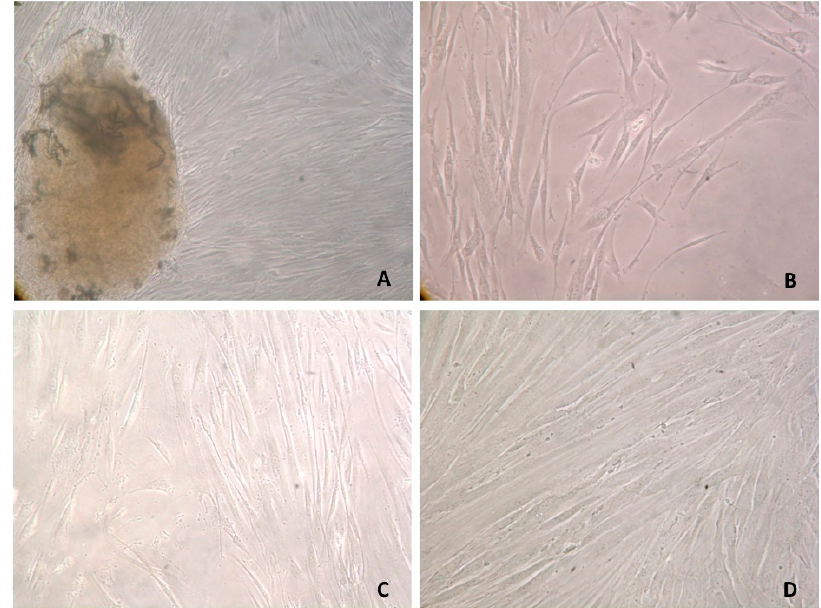
Figure 2. Human gingival fibroblasts (HGF) primary cultures. ( A ) Cells emerging from an explant, 25 days after culture establishment, 100×. ( B ) Cells emerging from an explant, 34 days after culture establishment, 100×. ( C ) HGF, one passage, low confluence, 200×. ( D ) HGF, tenth passage, high confluence, 400×.